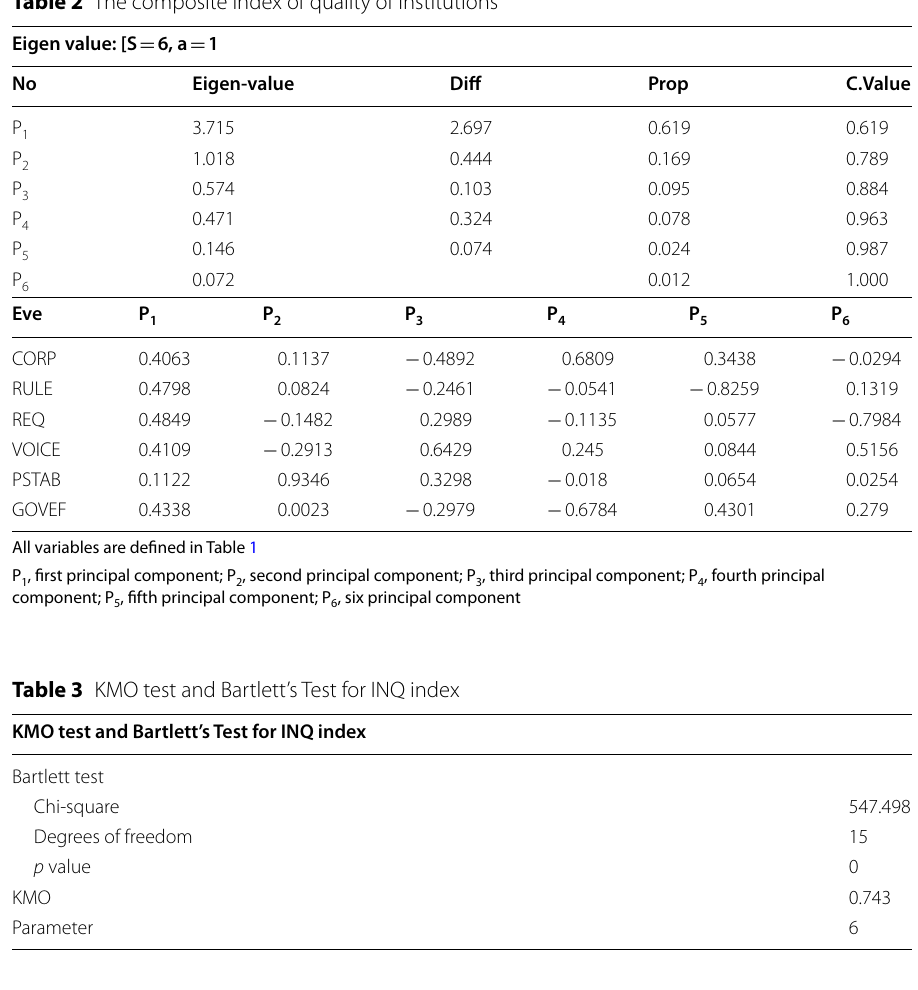
Table 2 The composite index of quality of institutions